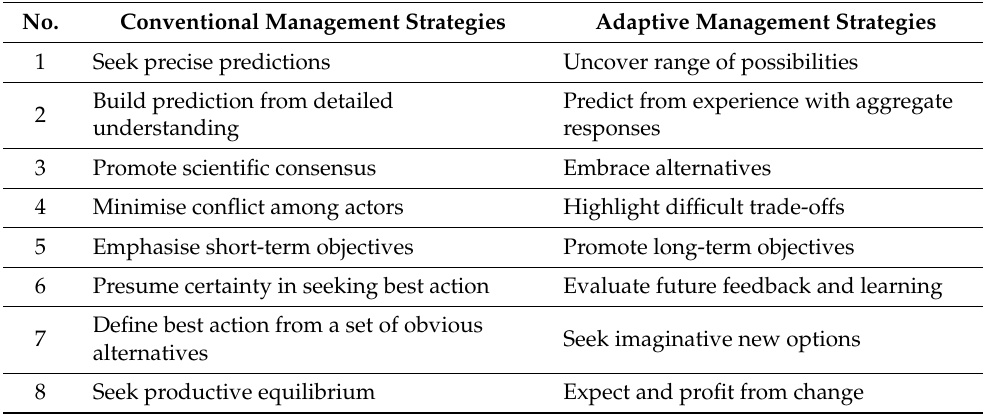
Table 4. Contrast between conventional and adaptive management approaches (adopted from [78] p. 8, presented in